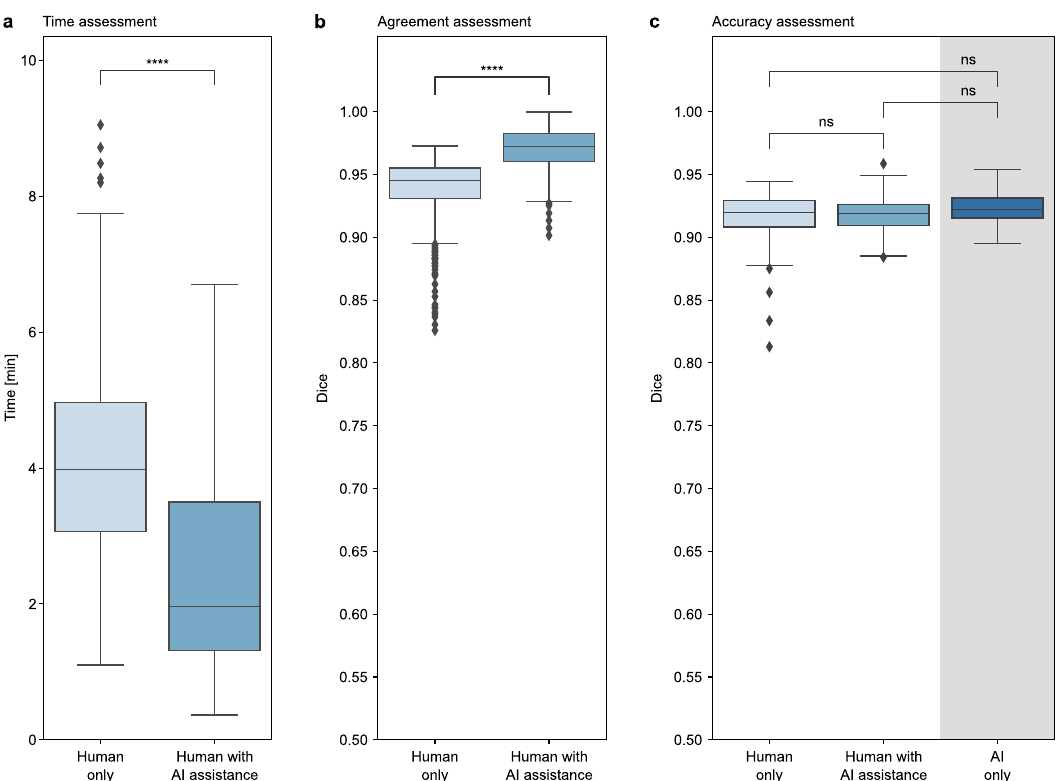
Fig. 2 Comparison of human only, AI-assisted and AI-only segmentation. In a prospective assessment, 8 radiation oncology experts individually segmented the heart in 20 breast cancer treatment CTs. In a subsequent session, the same patients were segmented again with AI assistance. a The analysis shows that AI-assisted segmentation signi fi cantly reduces the time needed, ( b ) and agreement between medical experts signi fi cantly increases. c Comparing the manual-only, AI-assisted and AI-only segmentations to the reference segmentations of a radiation oncology expert with several years of experience shows no signi fi cant differences in accuracy. Each box represents the interquartile range (IQR, 25th and 75th percentiles) and the centerline the median of the results. The whiskers represent minimum and maximum data points, excluding outliers. Outliers are de fi ned as greater than the 75th percentile + 1.5×IQR and smaller than the 25th percentile − 1.5×IQR and are denoted as